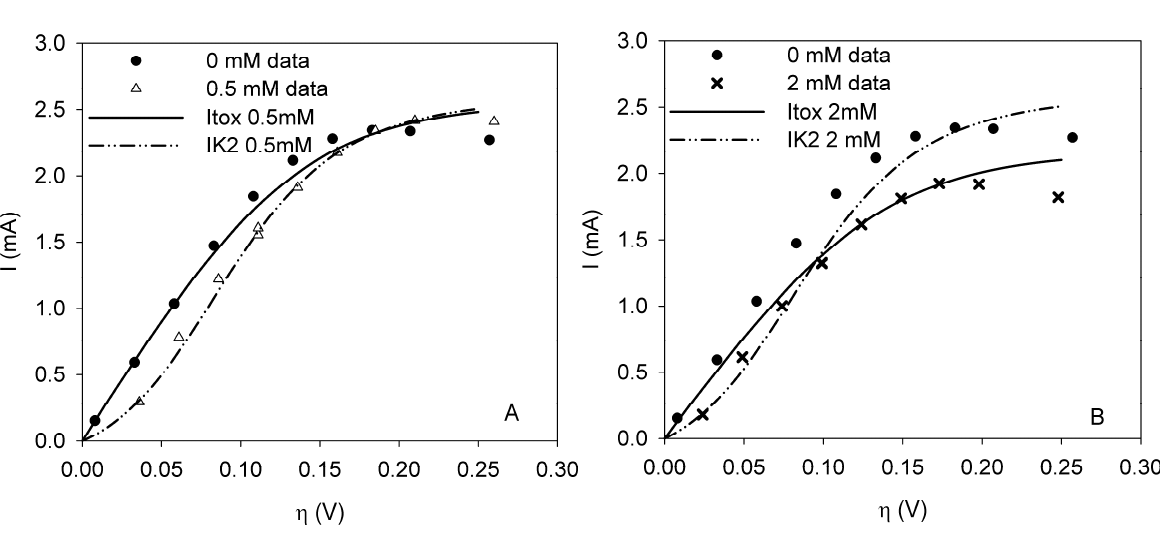
Figure 3. Polarization curves under clean conditions (dot) and when ferricyanide is present in the sensor at a dosage of ( a ) 0.5 mM (trangle) or ( b ) 2 mM (cross). Model Itox (solid line) and model IK2 (dot-dash-dot) are fitted to data from the curves with